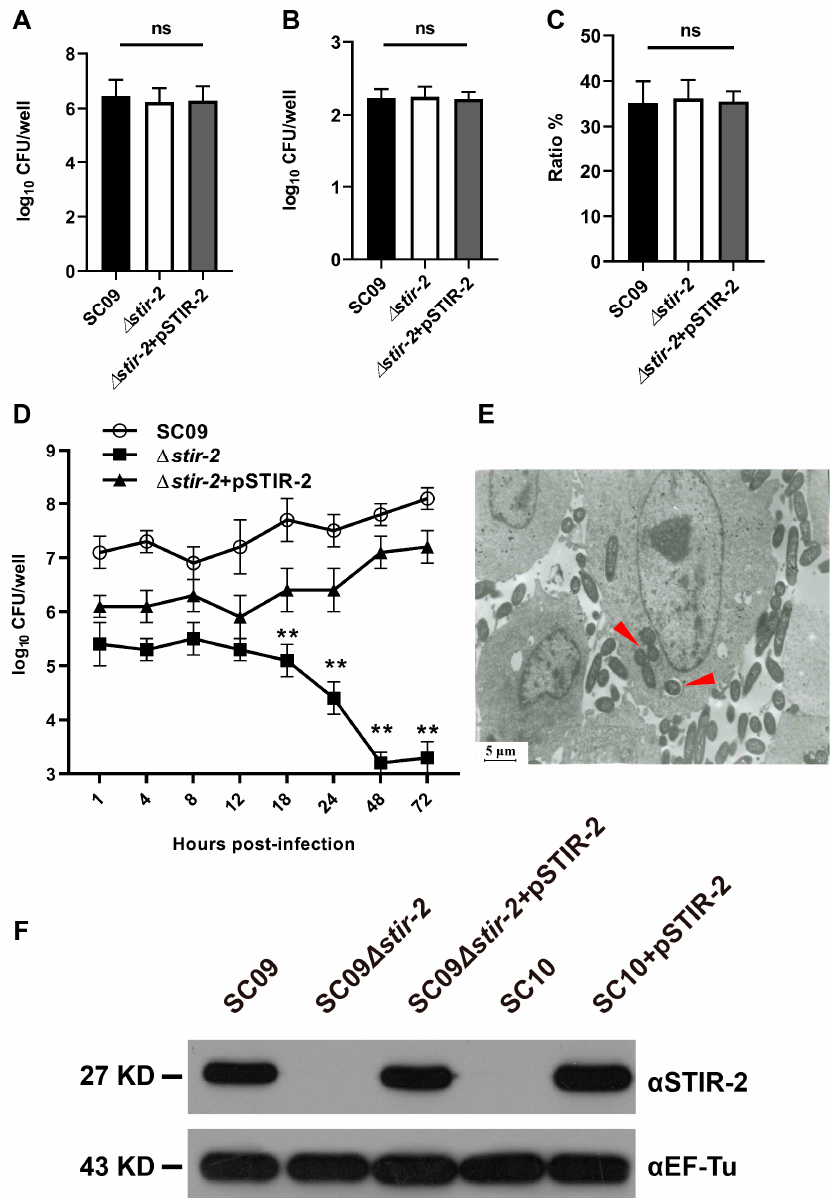
Figure 3. The knockout of the stir ‐ 2 gene in the Yersinia ruckeri SC09 strain affects intracellular bacterial survival but not bacterial adherence and invasion. Primary rainbow trout head kidney macrophages infected with the wild ‐ type Y. ruckeri SC09 strains, Y. ruckeri SC09 Δ stir ‐ 2 mutant, or Y. ruckeri ∆ stir ‐ 2 + pSTIR ‐ 2 mutant at a MOI of 1.5. There were no significant changes in bacterial adherence ( A ), invasion ( B) , and invasion ratios (number of intracellular bacteria/number of adherent bacteria) ( C ). ns, the means were not significantly different. ( D ) At 18, 24, 48, and 72 hpi (MOI = 1.5), the intracellular survival of the SC09 Δ stir ‐ 2 mutant was significantly lower than that of the wild ‐ type SC09 strain and ∆ stir ‐ 2 + pSTIR ‐ 2 mutant. ** p < 0.01. ( E ) Transmission electron micrographs of primary rainbow trout head kidney macrophages infected the wild ‐ type Y. ruckeri SC09 strain (red arrow) at 48 hours post infection (hpi). ( F ) Western blot analysis was performed on the bacteria used to infect primary rainbow trout head kidney macrophages. The knockout strain did not express STIR-2 (27 kDa), whereas the wild type strain and the complemented strain expressed STIR-2 (27 kDa). The cytoplasmic protein EF-Tu (43 kDa) was used as a